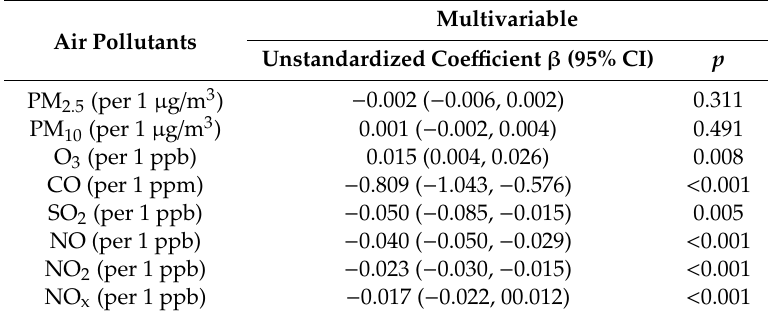
Table 2. Association of air pollutants with BMD T-score using multivariable linear regression analysis.